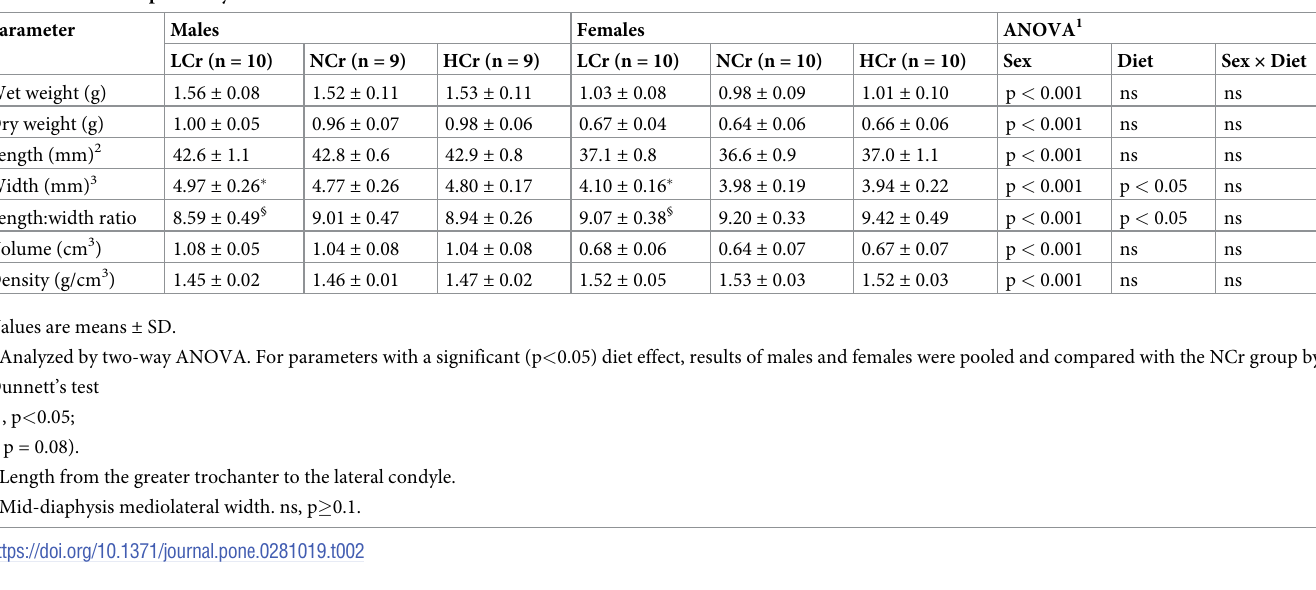
Table 2. Gross morphometry of rat